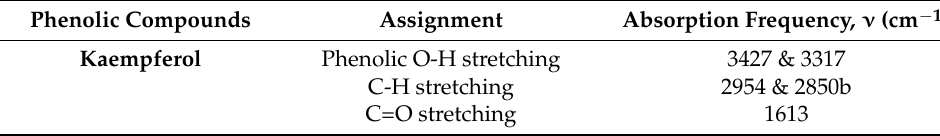
Figure 2. FT-IR SNV preprocessed spectra ( a ). ( i – v ) are the extended spectral regions related to different phenolics compounds. Table 2. Principal characteristics IR vibrations in the phenolics